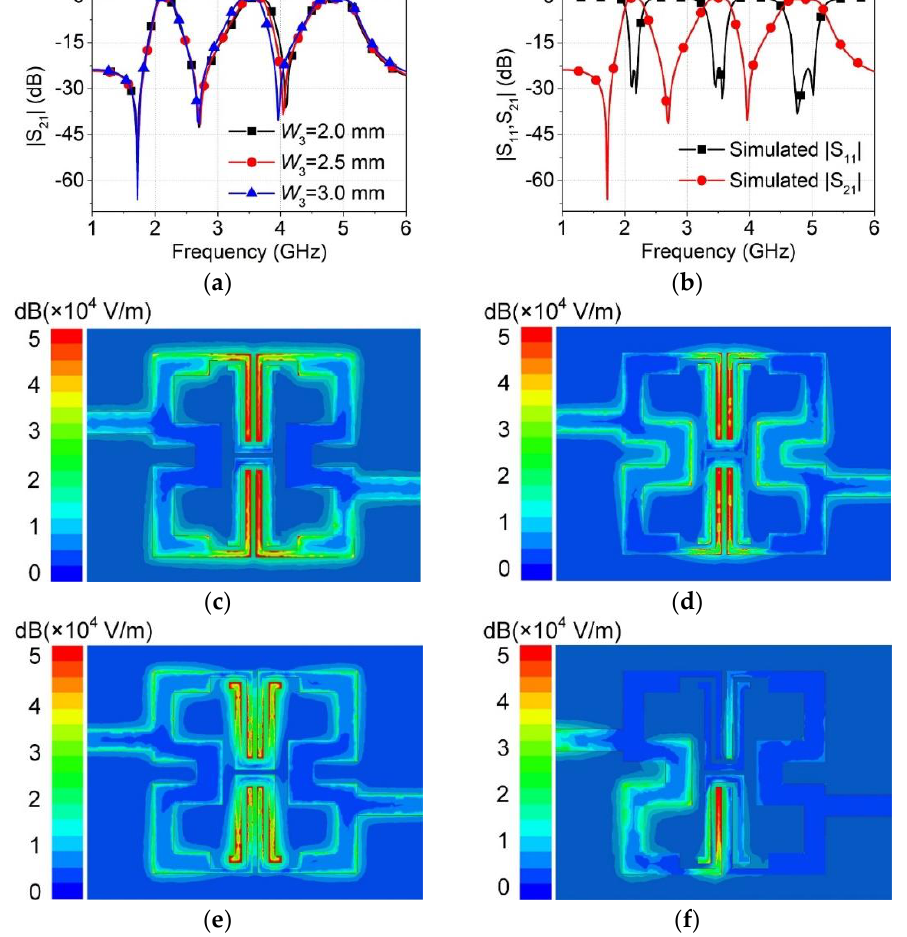
Figure 6. Simulation of a tri-wideband BPF. ( a ) The simulated |S 21 | response of the filter for various values of W 3 ; ( b ) Simulated |S 21 , S 11 | response of the tri-wideband BPF; ( c ) The simulated electric fields distributions of a tri-wideband BPF at 2.14 GHz; ( d ) The simulated electric fields distributions of a tri-wideband BPF at 3.5 GHz; ( e ) The simulated electric fields distributions of a tri-wideband BPF at 4.9 GHz; ( f ) The simulated electric fields distributions of a tri-wideband BPF at 4 GHz.